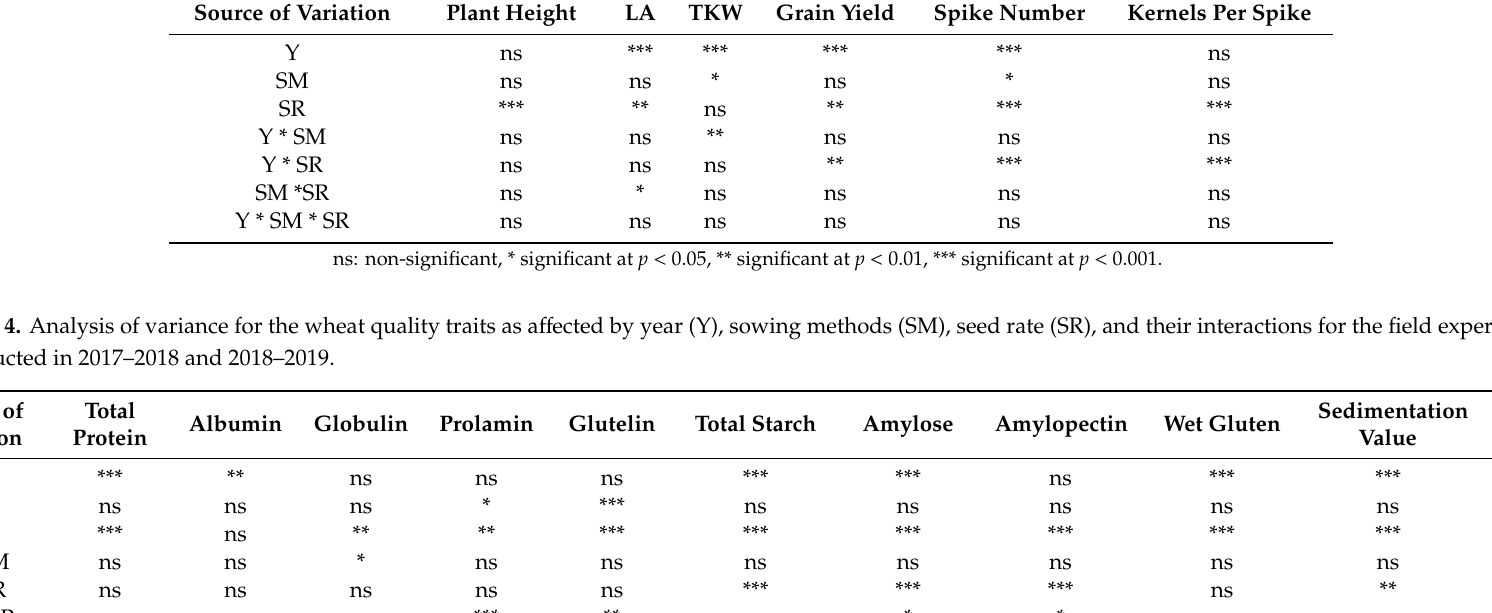
Table 3. Analysis of variance for the wheat yield and yield parameters as a ff ected by year (Y), sowing methods (SM), seed rate (SR), and their interactions for the field experiments conducted in 2017–2018 and 2018–2019. Leaf area (LA), thousand kernel weight (TKW).